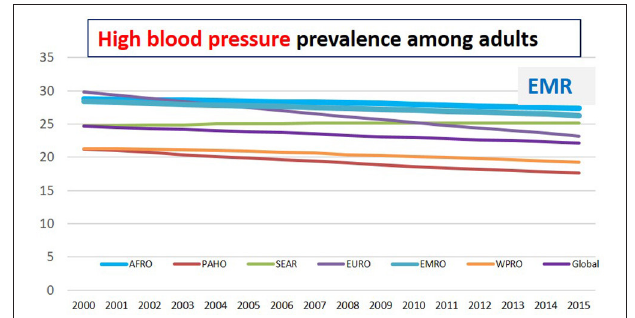
FIGURE 6 | High blood pressure prevalence among adults in different regions